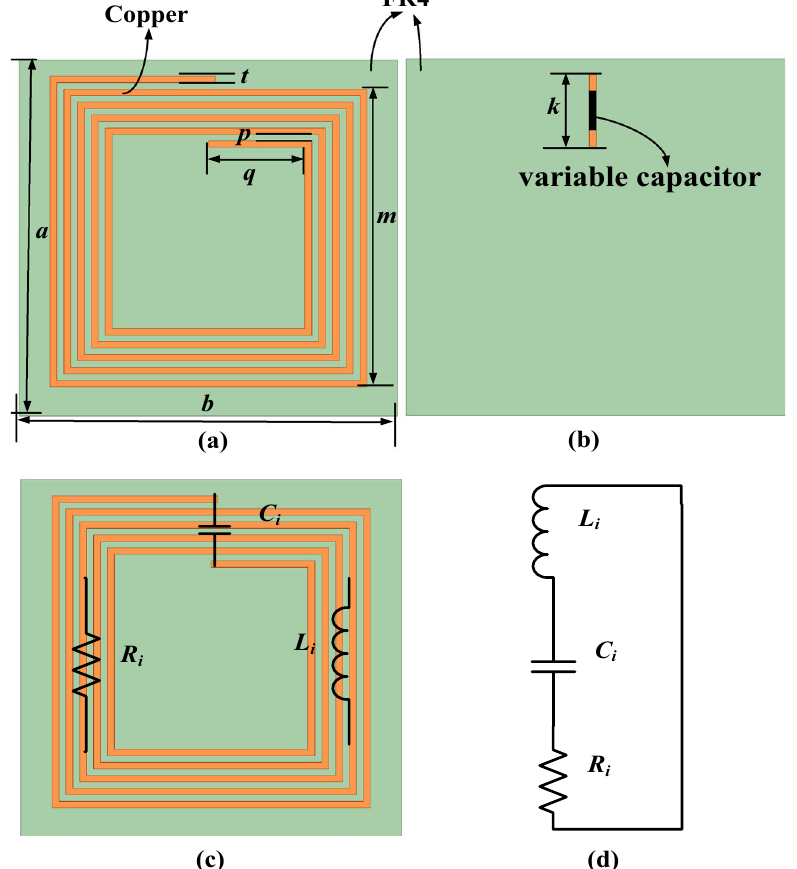
Figure 2. ( a ) Top and ( b ) bottom view of the coil unit cell, ( c ) the circuit schematic of the coil unit cell, ( d ) the equivalent RLC resonant circuit of the coil